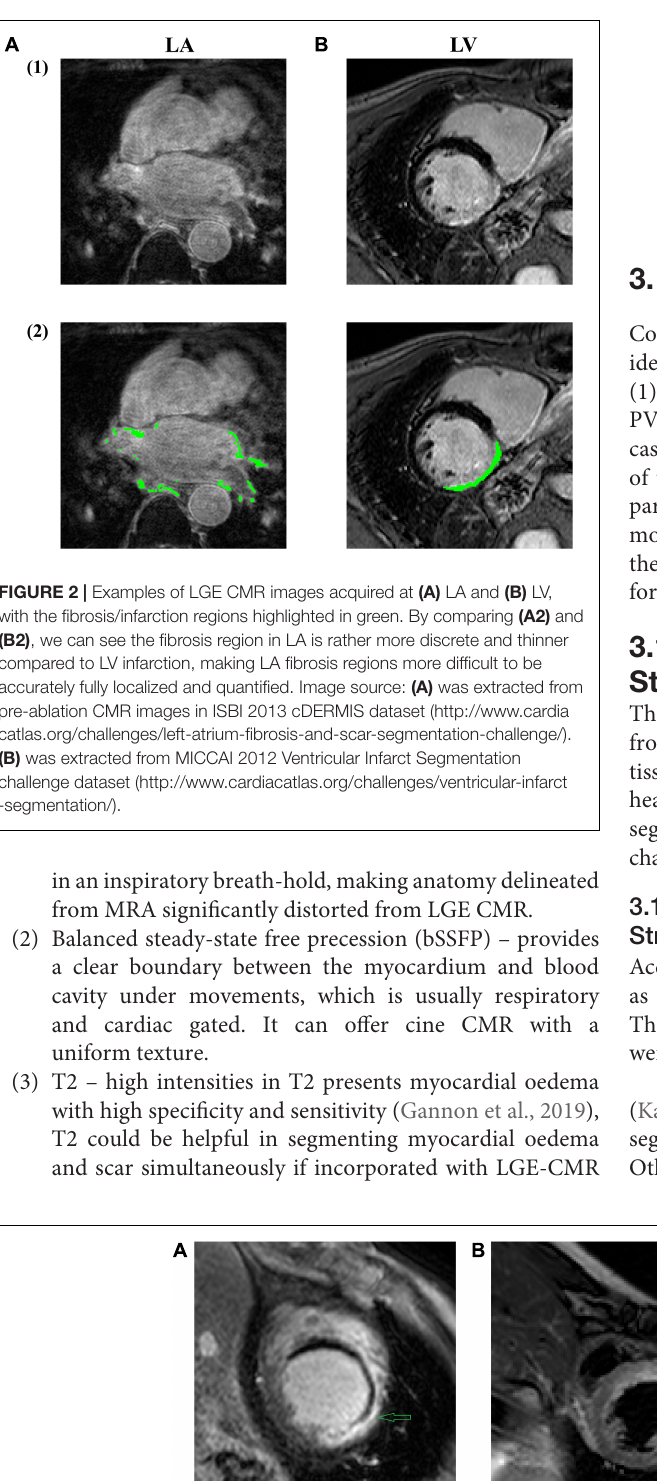
Frontiers in Physiology |